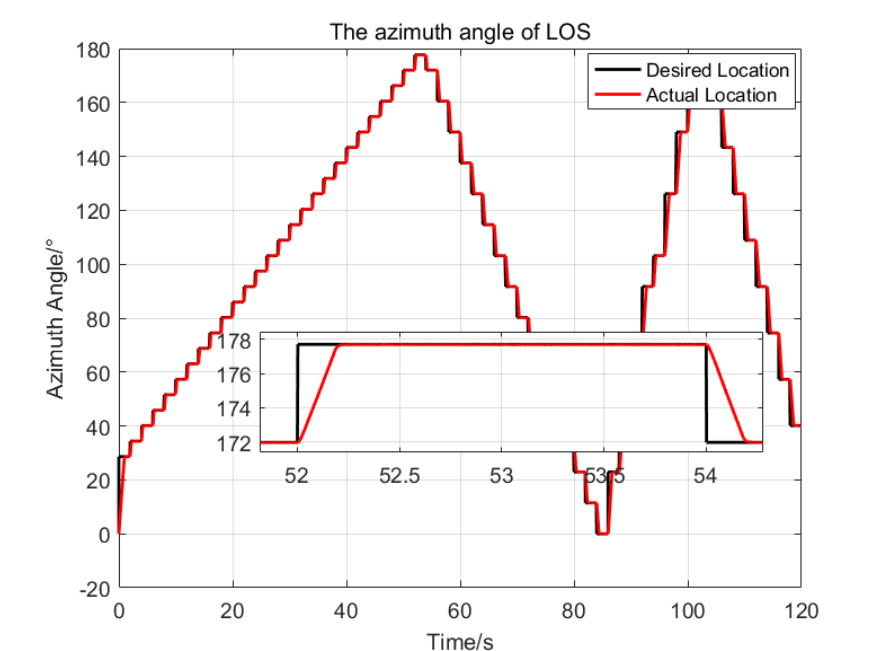
Figure 13. The tracking trajectory of the azimuth with the proposed